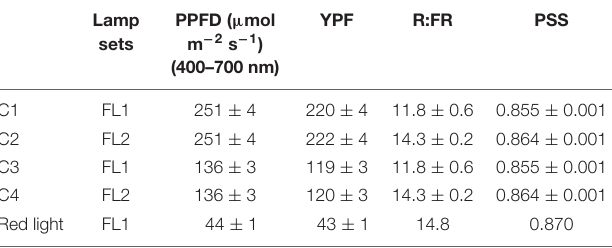
TABLE 1 | Characteristics of the light conditions for growing phyA , phyB , phyAB, and WT. Lamp sets